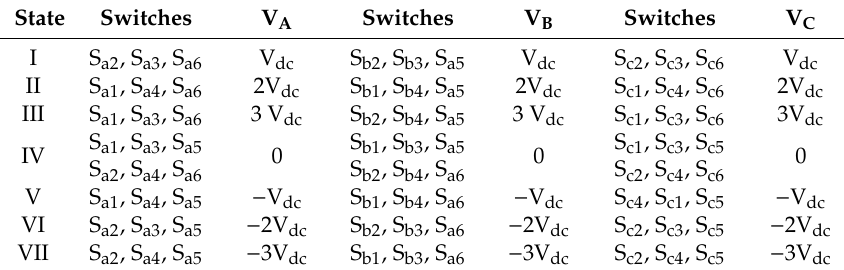
Table 1. Phase Switching